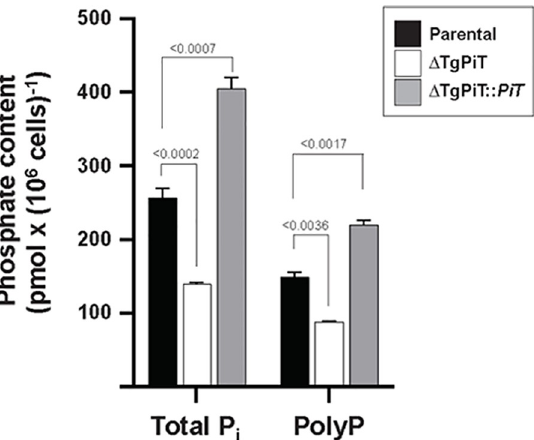
Fig 6. Determination of phosphate content in Δ TgPiT. Extracellular parental, Δ TgPiT and Δ TgPiT:: PiT parasites treated with perchloric acid were incubated with active or inactive exopolyphosphatase to measure inorganic phosphate. Total P i corresponds to free monomeric P i and polyP. The concentrations of polyP were deduced from values obtained on exopolyphosphatase-treated samples (giving total P i concentrations) subtracted from values obtained on denaturated exopolyphosphatase-treated samples (giving free Pi concentrations). Values are mean ± SD, n = 3 independent assays. p values were calculated using Fisher’s LSD test.